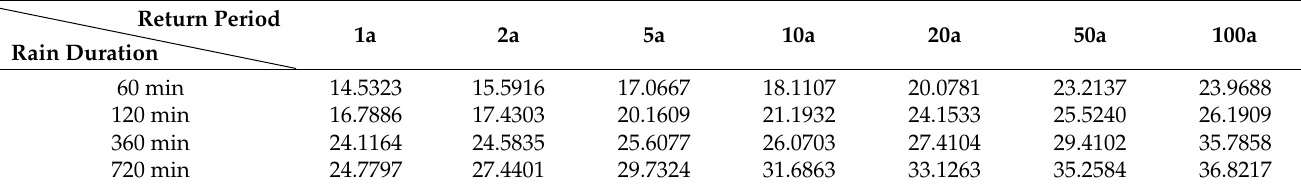
Table 6. Inundation area of all the rainstorm scenarios. Inundation area (km 2 ).